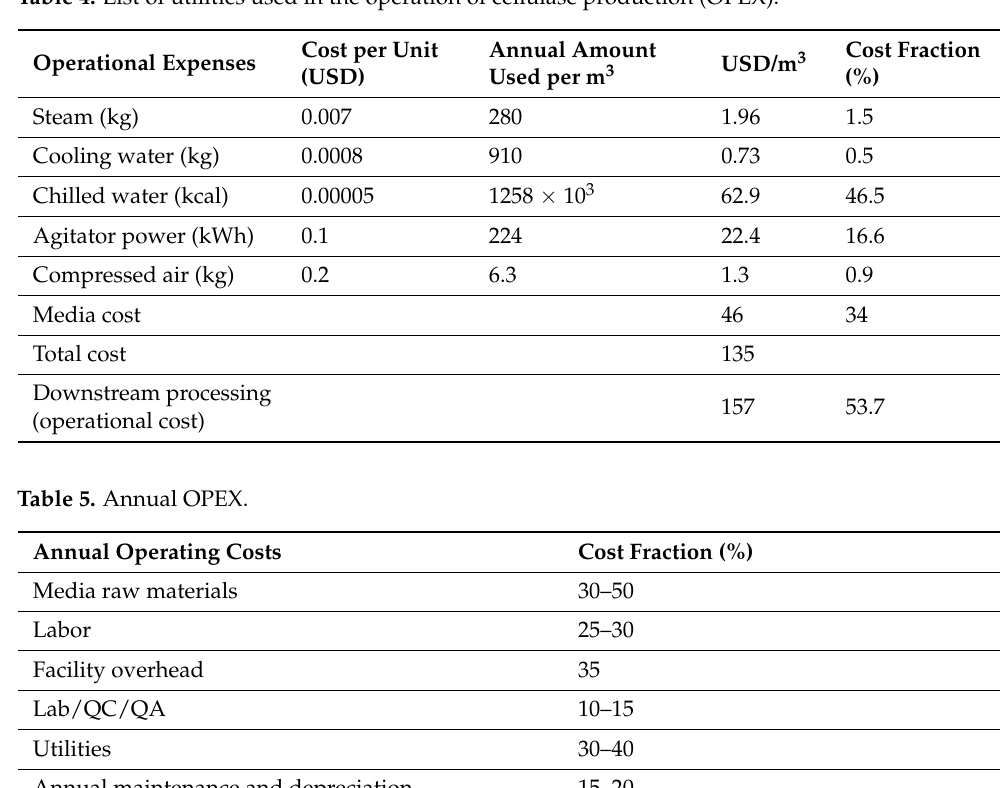
Table 4. List of utilities used in the operation of cellulase production (OPEX).